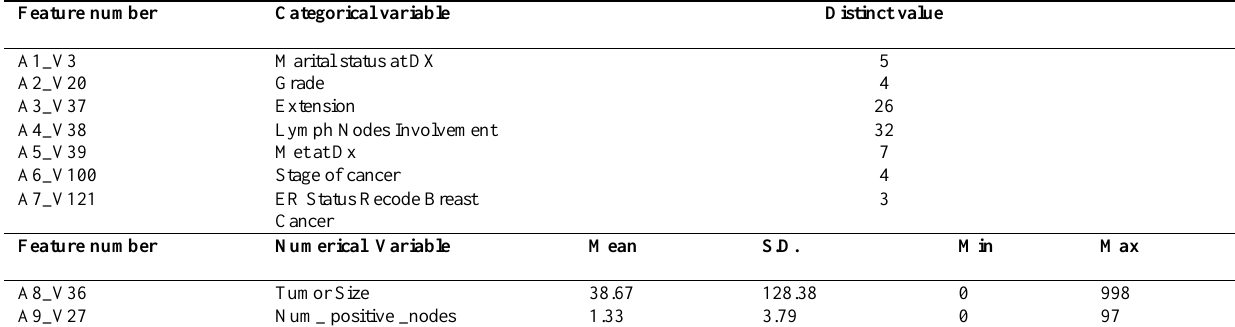
Table 2. Summaries of predictor variables selected by applying PSO_CFS to dataset_1.